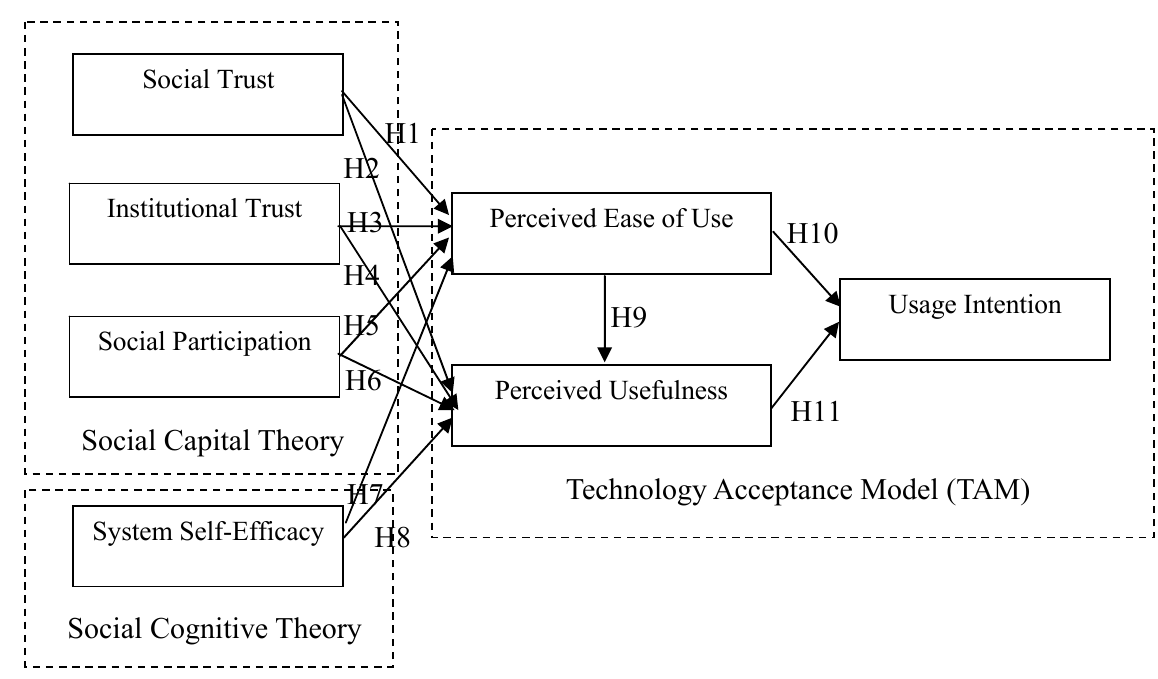
Figure 1. The Proposed Research